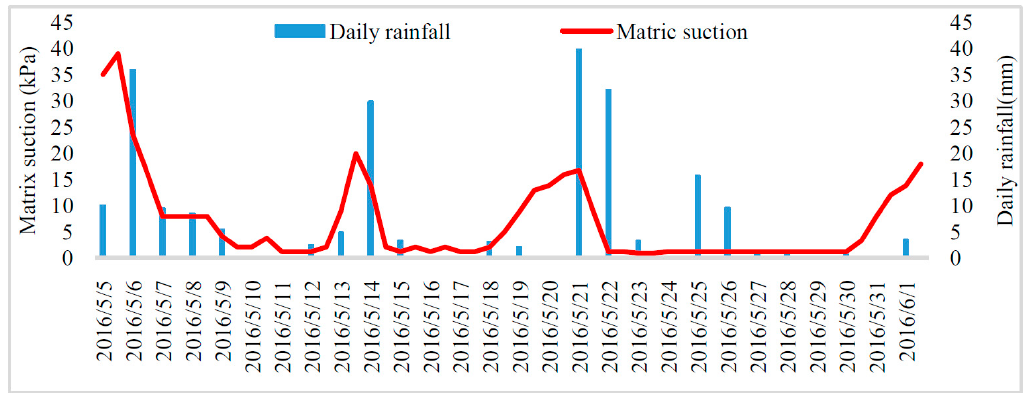
Figure 6. Times series of the daily rainfall and matric suction observed by real-time monitoring sensors from 5 May to 23 May 2016 in the top soil of the landslide monitoring site.